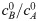
Experiments: Test of reciprocal relationships from initial conditions of cathodic and anodic mass transfer limited pre-polarizations for system where the bulk concentration ratio cB0/cA0 = 2.A) Relaxation of concentrations from initial condition corresponding to anodic pre-polarization (V = 200mV) at equilibrium potential (OCP = -197mV) B) Relaxation of concentrations from initial condition corresponding to cathodic pre-polarization (V = -1000mV) at equilibrium potential (OCP = -197mV) C) disk currents from both anodic (bold) and cathodic (solid) initial conditions and their scaled sum iA/2 + iC (dashed line) D) ratio of concentrations cB(t)/cA(t) with a dashed line representing the bulk concentration ratio cB0/cA0 = 2.